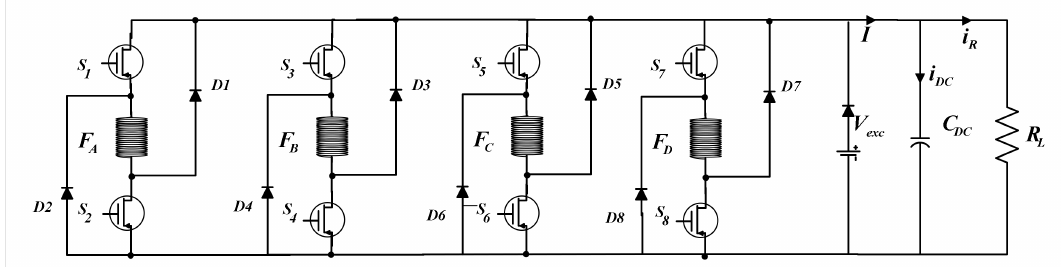
Figure 3. Schematic of the Asymmetric Half bridge